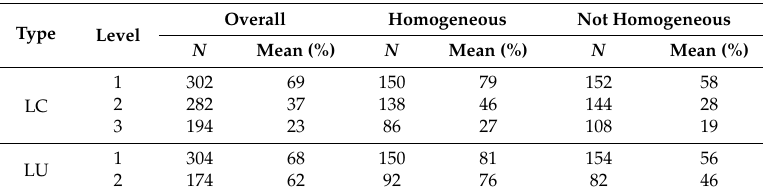
Table 3. Agreement between LUCAS 2015 and FotoQuest in land cover (LC) and land use (LU) for three groups of points: Overall agreement, agreement at homogeneous points, and agreement at not homogeneous points in percentage. Number of points for each group ( N ) is shown.